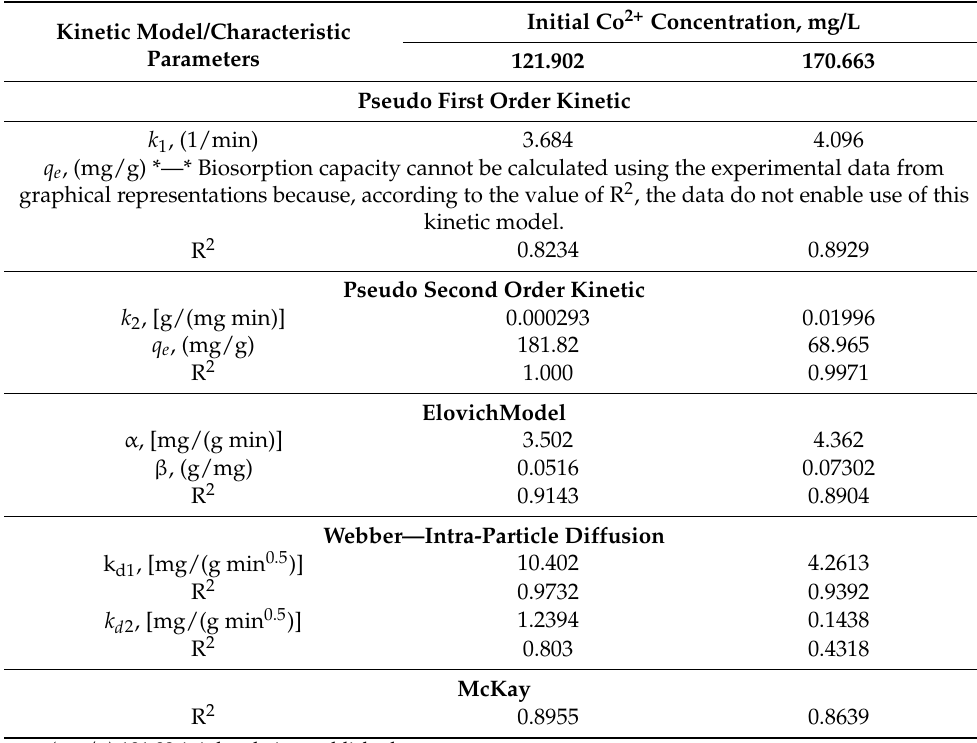
Table 1. Kinetic parameters for the Co 2+ ions biosorption onto OxC25 hydrogel.